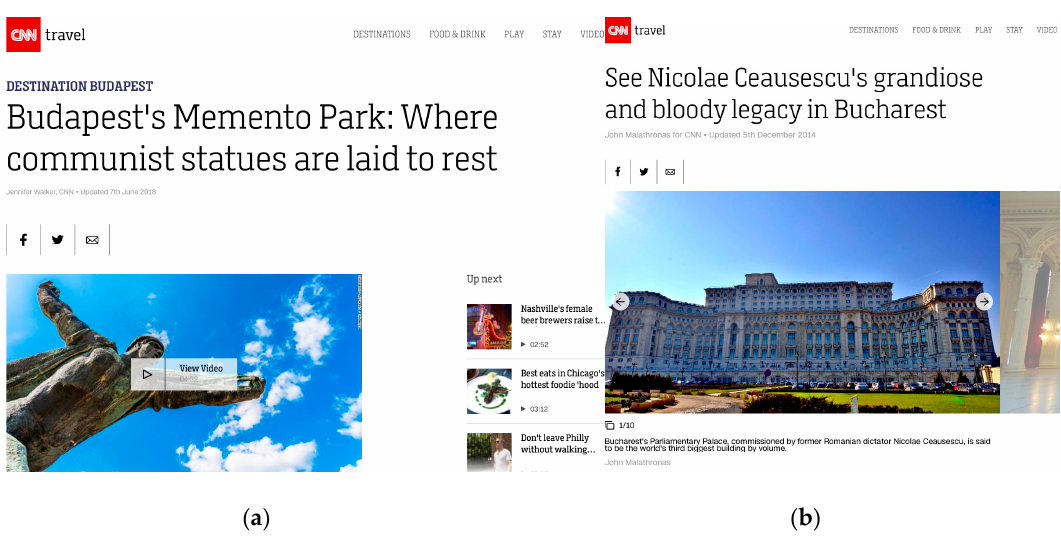
Figure 4. Cities from the CEE region in the focus of the US American broadcaster, CNN. ( a ) Memento Park was described as a must-see “monumental cemetery”; ( b ) visitors are invited to see the “grandiose and bloody legacy in Bucharest”. Screenshots, 2018-08-10. ( a ) https://edition.cnn.com/travel/article/memento-park-budapest-hungary/index.html; ( b ) https://edition.cnn.com/travel/article/ceausescu-trail-bucharest-romania/index.html.